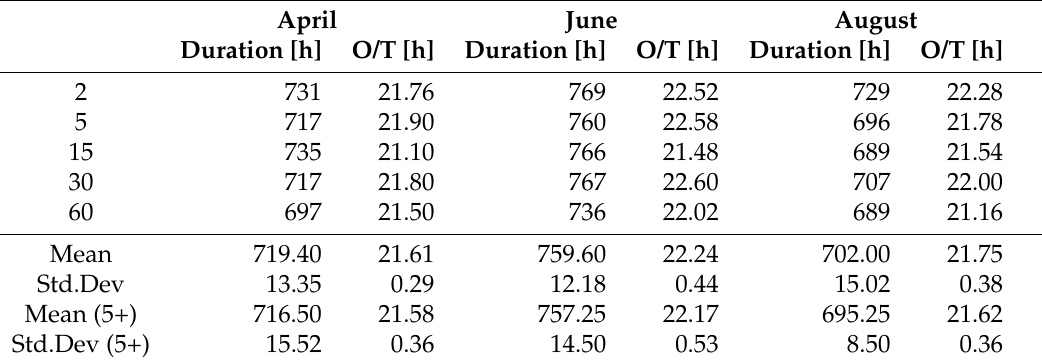
Table 9. Results of different optimization times for three